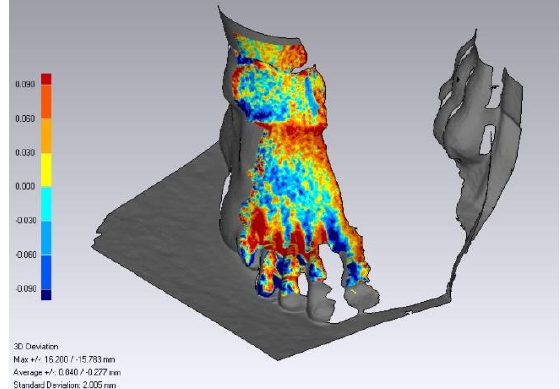
Figure 2. Residuals after TLS